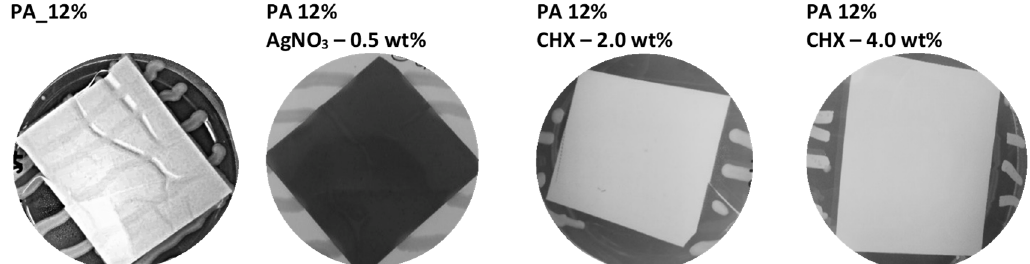
Figure 2. Examples of antibacterial activity test results for PAs n. 8 (PA_12%), n. 11 (PA 12% 0.5 wt% of AgNO 3 ), n. 12 (PA 12% 2.0 wt% CHX), n. 13 (PA 12% 4.0 wt% CHX), and S. aureus CCM 4516. Around the CHX PAs, the inhibition zones are evident, whereas the other PAs show no inhibition zone. Only for the neat PA can bacterial growth on the material´s surface be observed. Table 2. Average inhibition zones, inhibitory rates, and log 10 suppression of PAs n. 8–n. 13 for S. aureus CCM 4516 both shortly (1st analysis) and after nine months (2nd analysis) after PA preparation. Inhibition zones were measured from the edge of the material. “N” means that the bacterium grew under the PA; “0” means that the bacterium did not grow under the PA, but there were no inhibition zones around. p -values confirm no significant differences between the 1st and 2nd measurement. Inhibition Zones (mm) Material